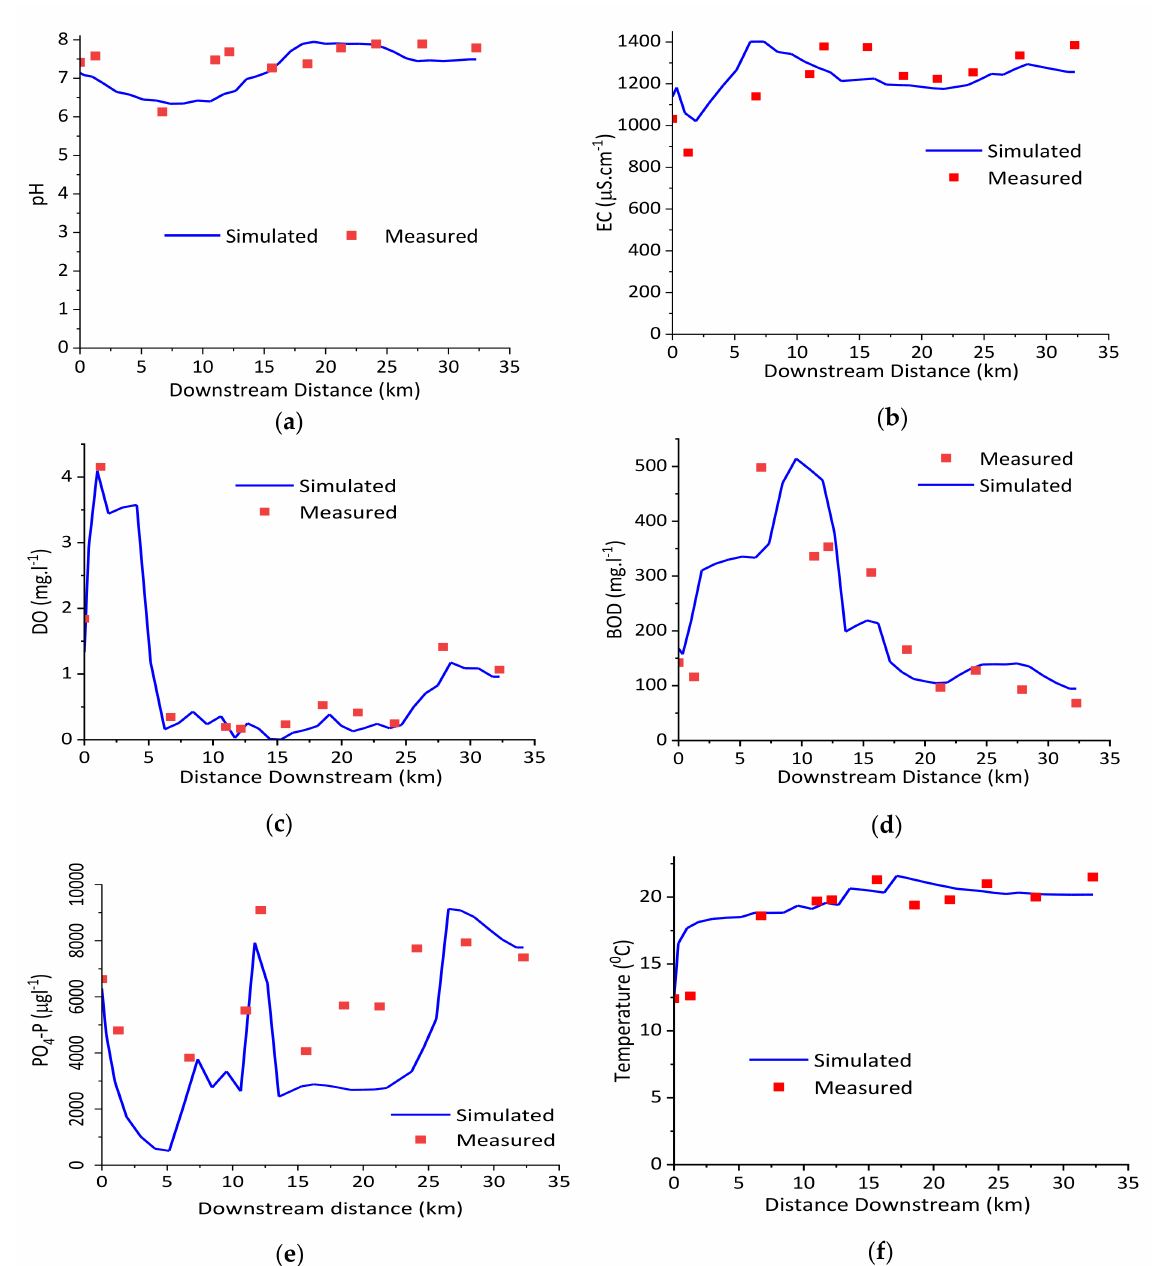
Figure 5. Simulation of QUAL2kw for selected water quality constituents in LAR (validation): ( a ) pH, ( b ) Electrical Conductivity (EC) ( µ s/cm), ( c ) Dissolved Oxygen (DO) (mg/L), ( d ) Carbonaceous Biochemical Oxygen Demand (CBOD) (mg/L), ( e ) Phosphate (PO 4 -P), ( f ) Temperature ( ◦